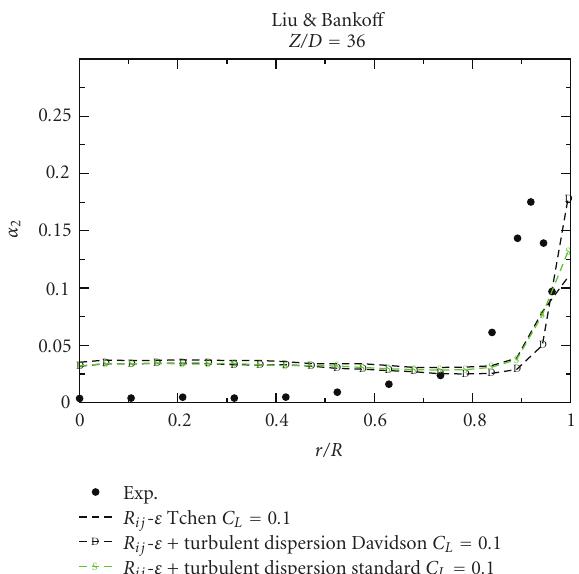
Figure 4: Radial profile of void fraction, comparisons of turbulent dispersion forces with CL = 0 .